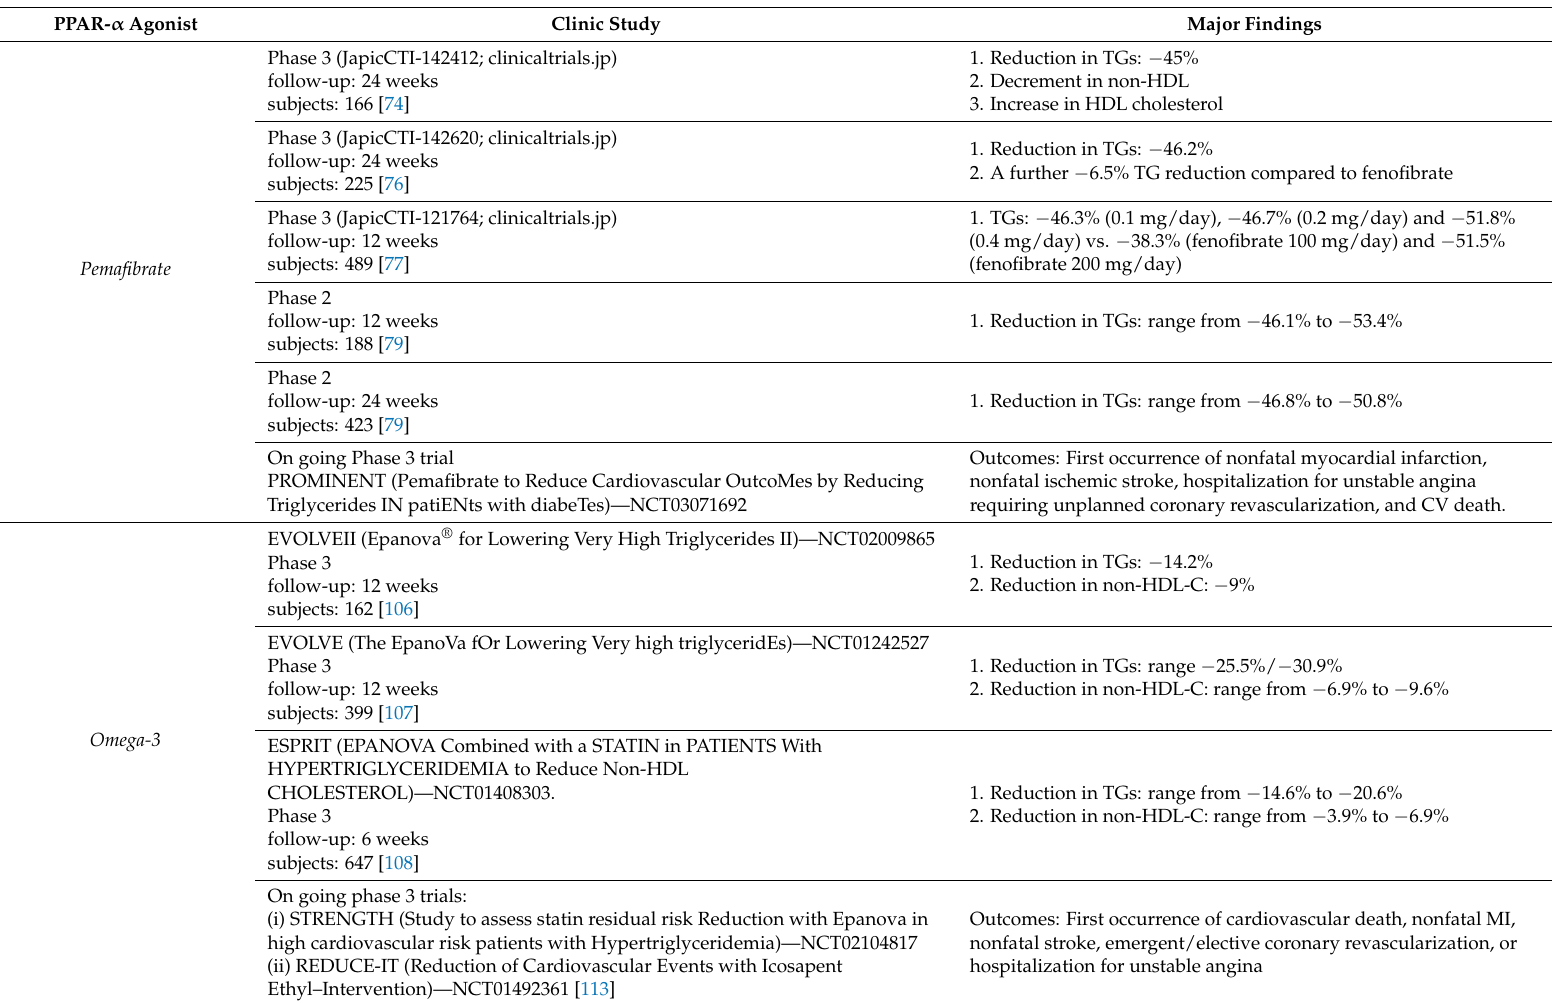
Table 2. Effect of PPARs on the features of metabolic syndrome—evidence from clinical